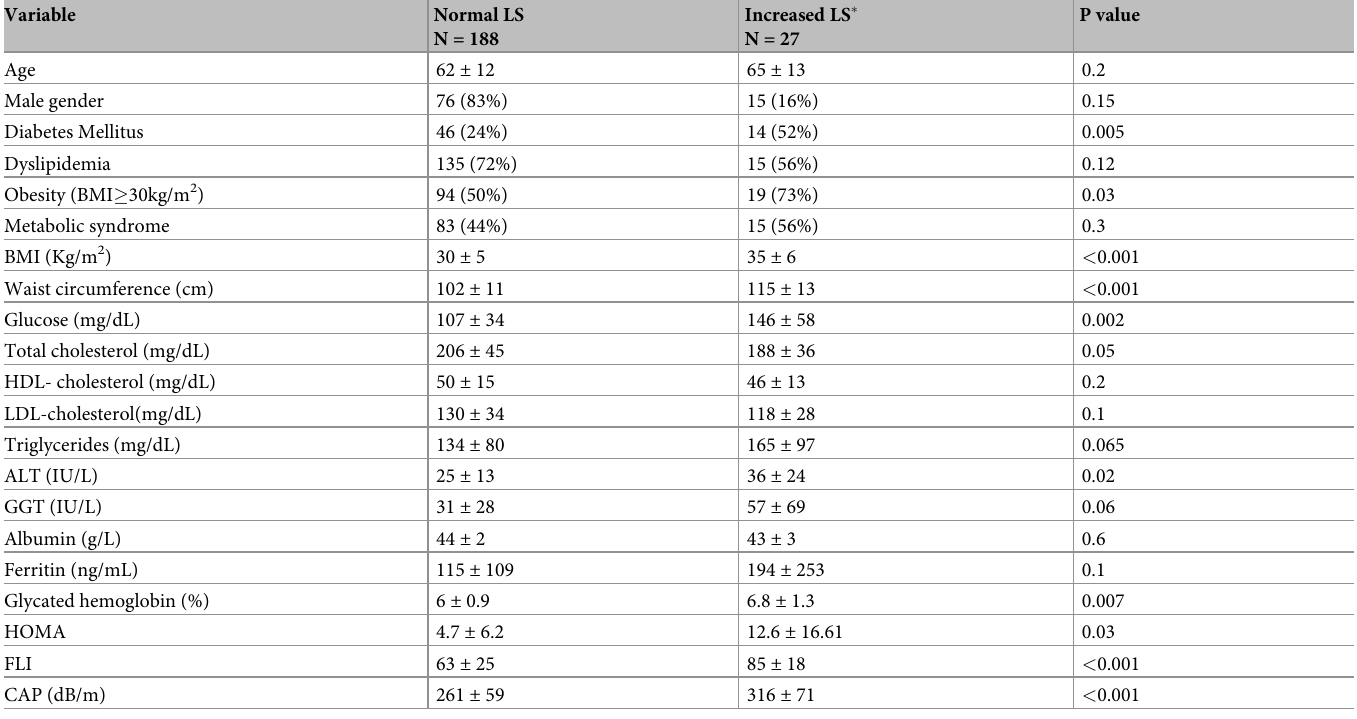
Table 7. Comparison of characteristics of subjects with risk factors for NAFLD categorized according to liver stiffness.